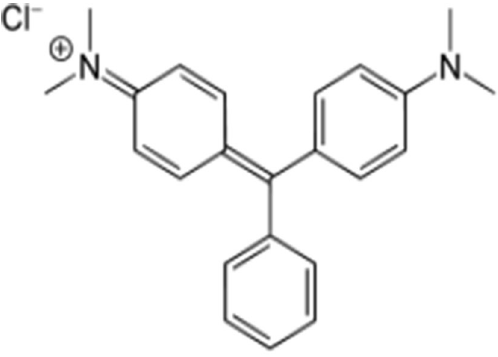
Fig. 1 Chemical structure of malachite green